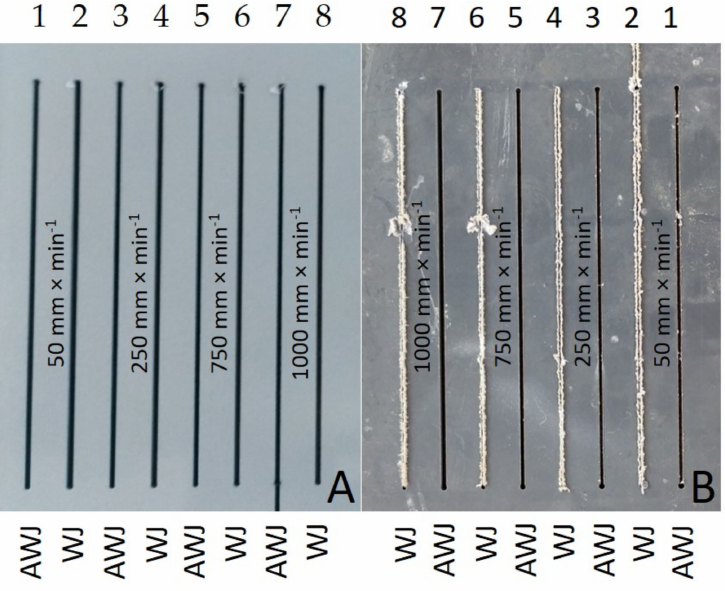
Figure 9. Cutting gaps in PVC-U + POLURAN: ( A ) WJ and AWJ inlet; ( B ) WJ and AWJ